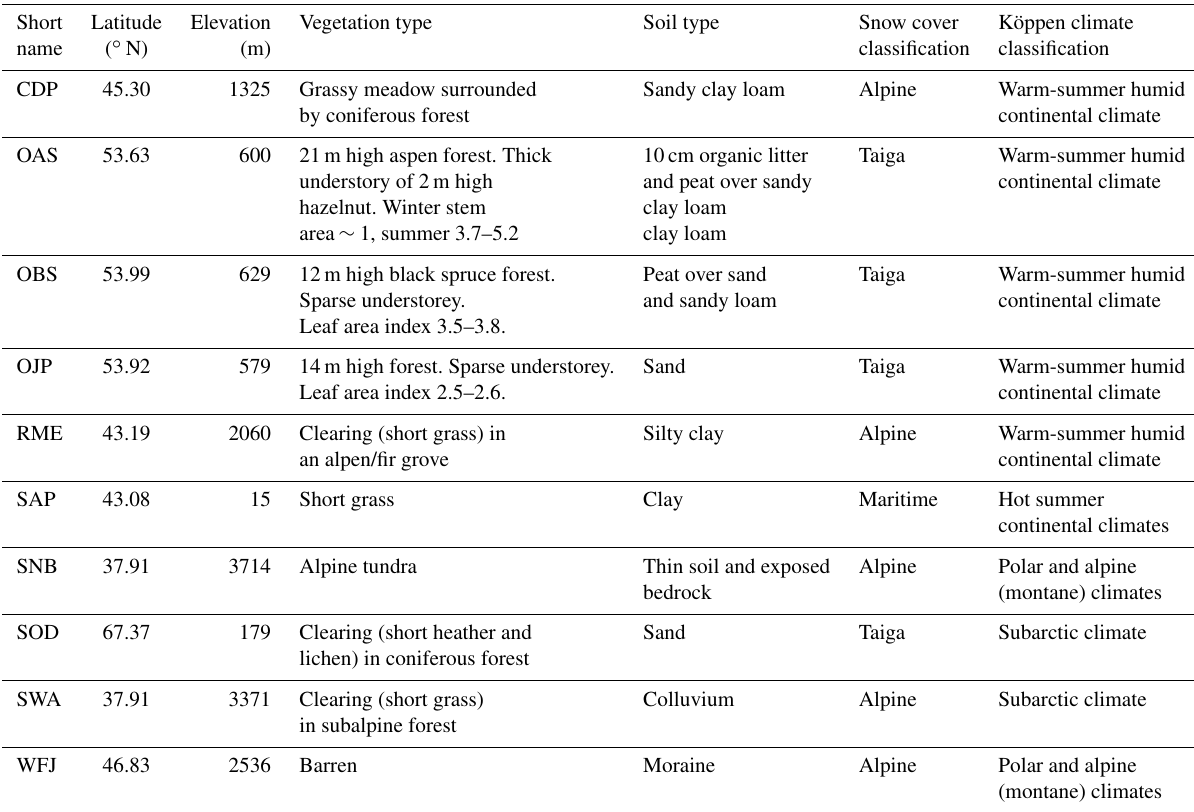
Table 2. Geographic characteristics of the 10